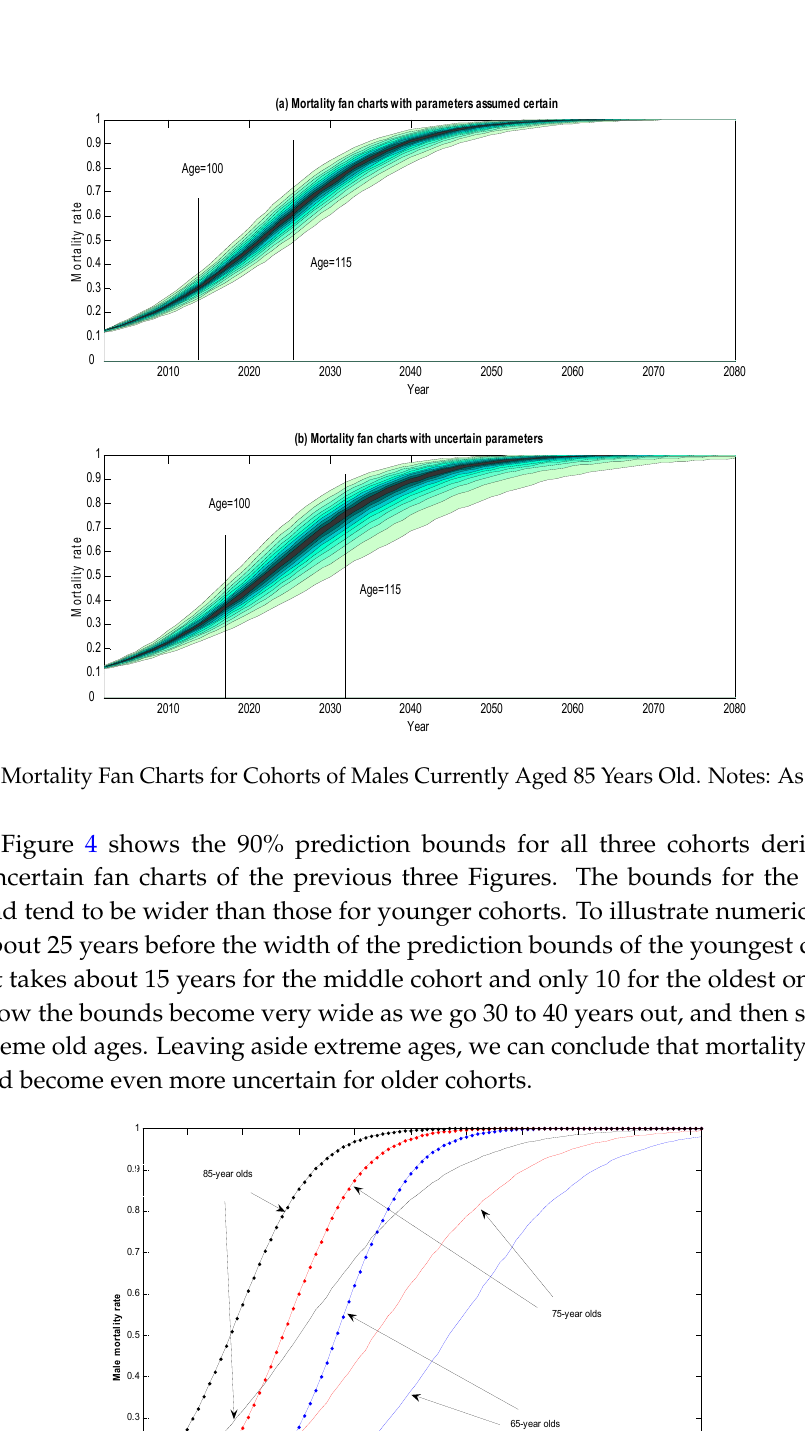
(b) Mortality fan charts with uncertain parameters